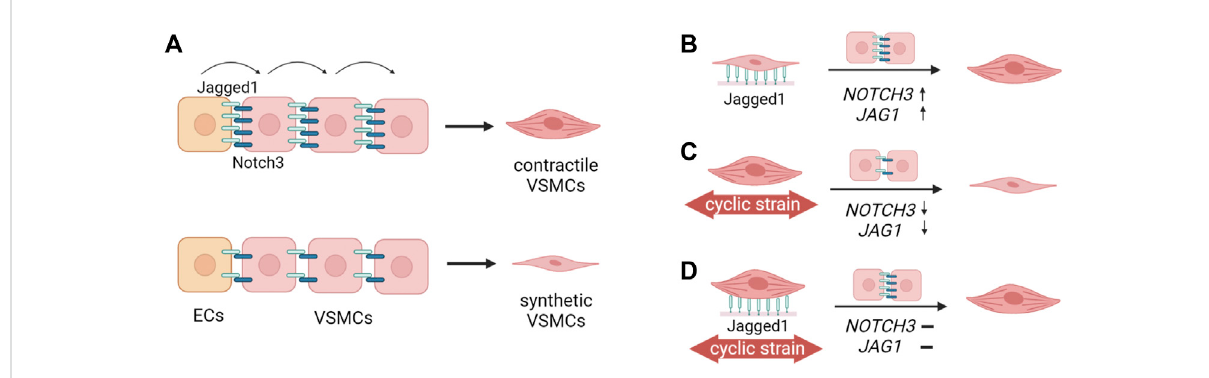
FIGURE 11 Schematicsummaryofthe fi ndings. (A) Jagged1-mediatedNotchsignalinginitiatedbytheendothelialcells(ECs)propagatesthroughthevessel wall (Hoglund and Majesky, 2012; Mander fi eld et al., 2012) and determines the differentiation of vascular smooth muscle cells (VSMCs) towards the contractilephenotype(Domengaetal.,2004;Doietal.,2006;Highetal.,2007).HighJagged1-Notch3activityleadstothecontractilephenotypeof VSMCs, and low Jagged1-Notch activity is associated with the synthetic phenotype of VSMCs. (B) In this study, we showed that Jagged1- induction upregulated NOTCH3 and JAG1 expression, and increased the contractile features of VSMCs. This shows that Notch signaling directly in fl uences the VSMC phenotype. (C) The application of strain to contractile VSMCs downregulates NOTCH3 and JAG1 expressions, and switches contractile VSMCs towards a more synthetic phenotype (D) Jagged1-induction during the application of strain partially rescues the contractile phenotype of VSMCs. Thus, Notch signaling plays an important role in strain-mediated phenotypic switching of VSMCs (The fi gure was created with